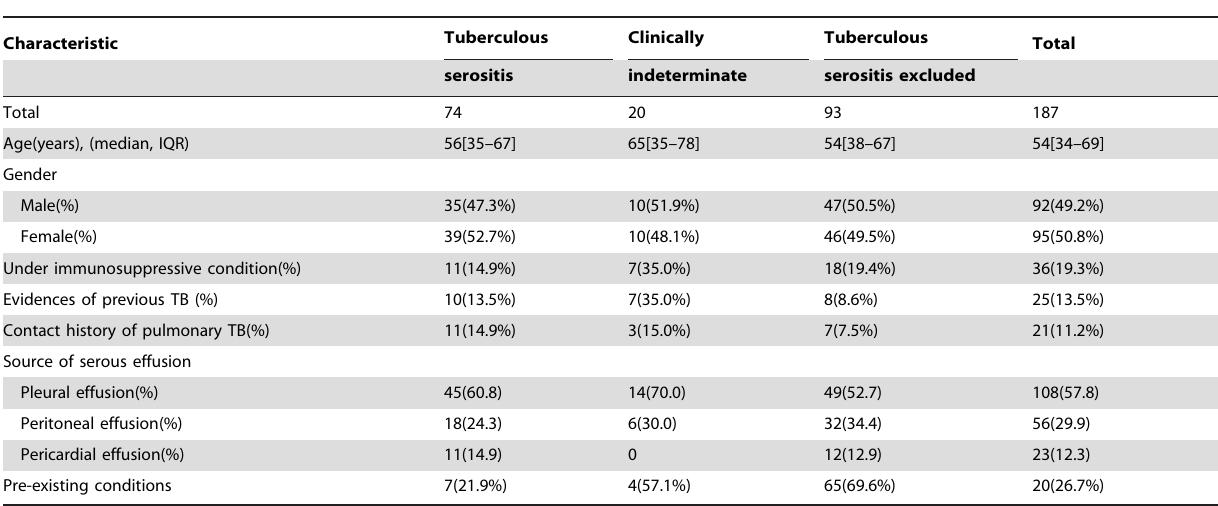
Table 2. Demographic and characteristics of the study